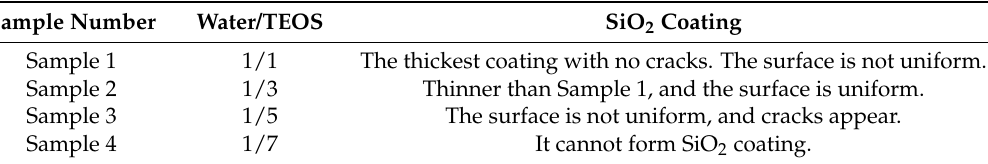
Table 1. Result of samples with different water/TEOS ratio.